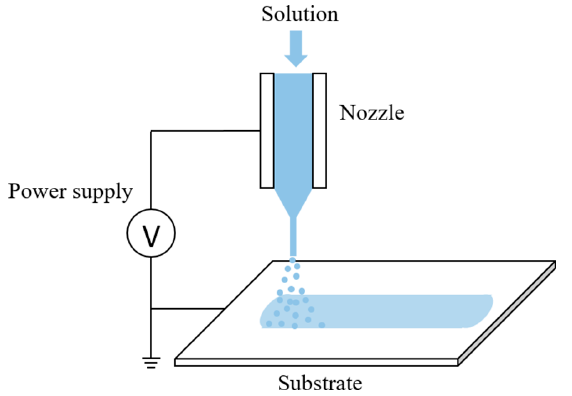
Figure 1. Schematic of experimental setup.